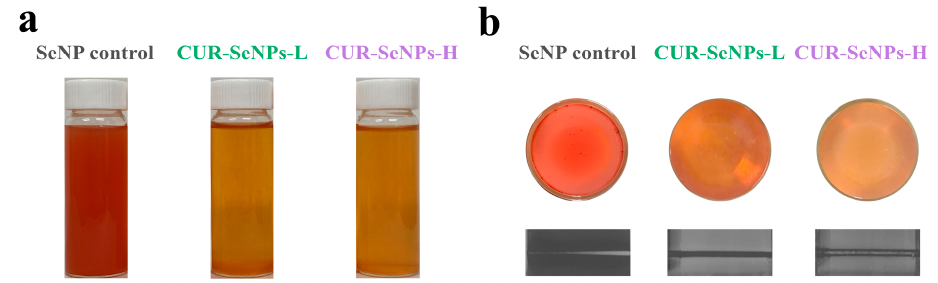
Figure 1. ( a ) Front view, ( b ) bottom view and grayscale photograph under 650 nm-laser light of CUR-SeNPs